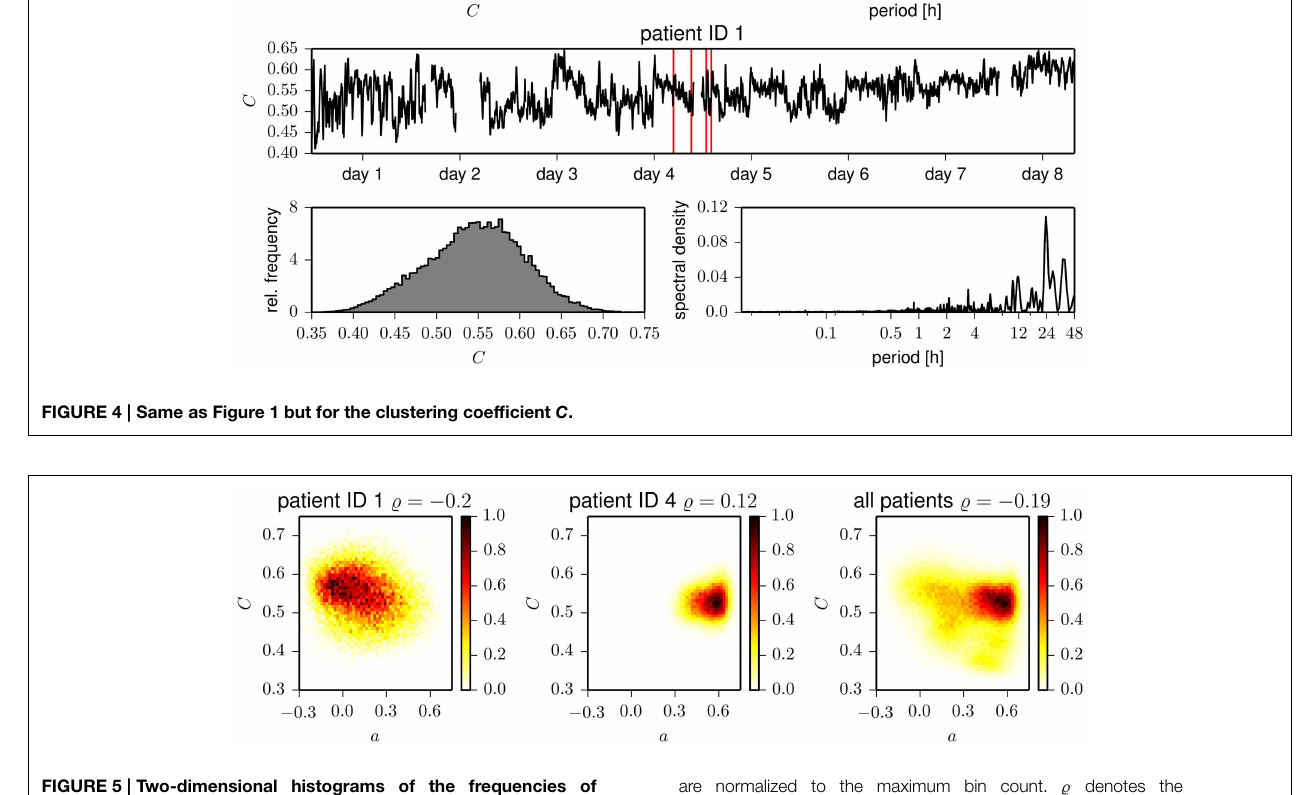
are normalized to the maximum bin count. ̺ denotes the Pearson correlation coefficient which we determined for the respective